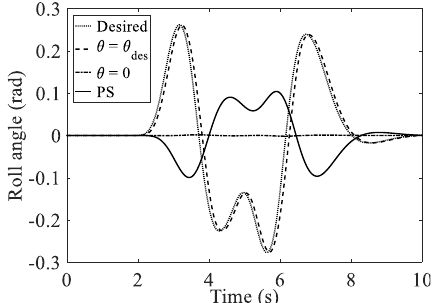
Figure 17. Roll angle of the vehicle body.